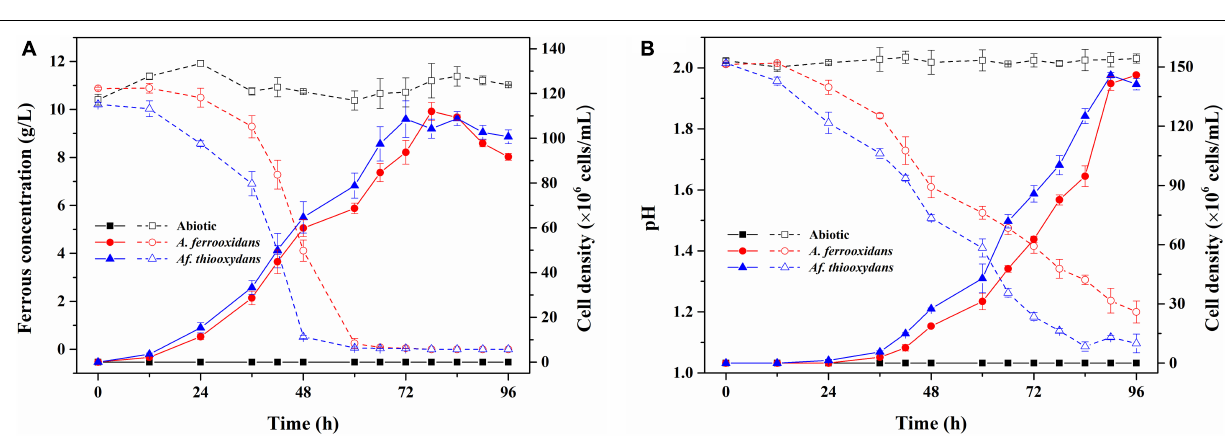
FIGURE 2 | The growth and iron/sulfur oxidation rate of Af. thiooxydans ZJ and A. ferrooxidans ATCC 23270 under the same culture conditions (pH 2.0, Temperature 30 ◦ C). The dashed lines represent the ferrous concentration in the left y -axis and the solid lines represent the cell density in the right y -axis (A) . The dashed lines represent the pH in the left y -axis and the solid lines represent the cell density in the right y -axis (B)